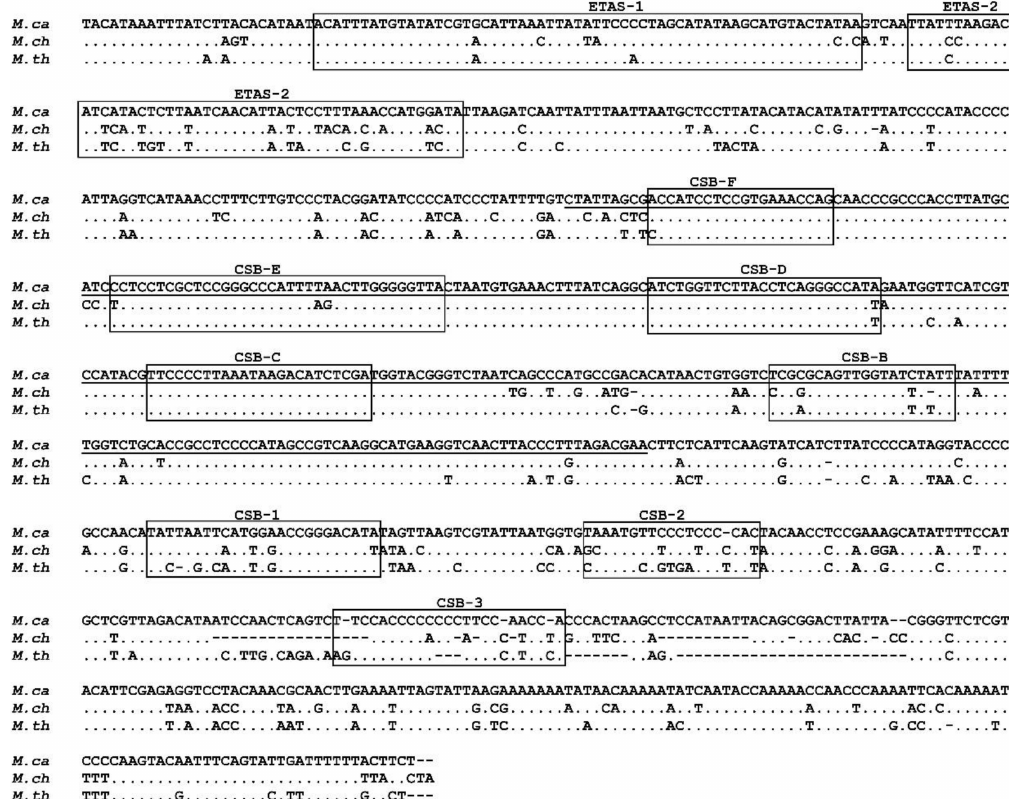
Figure 3. Nucleotide sequence alignment of the control region of Microtus cabrerae ( M. ca ), M. chrotorrhinus ( M. ch ) and M. thomasi ( M. th ). Dots indicate the identity of the nucleotides and dashes the indels. All the conserved sequences identified are included in boxes: the two conserved extended termination-associated sequences (ETAS1 and ETAS2) in Domain I, five conserved blocks (CSB-F, E, D, C, B) in the central conserved Domain II (underlined) and three conserved blocks (CSB1, CSB-2 and CSB-3) in Domain III. Dots indicate identity and dashes denote